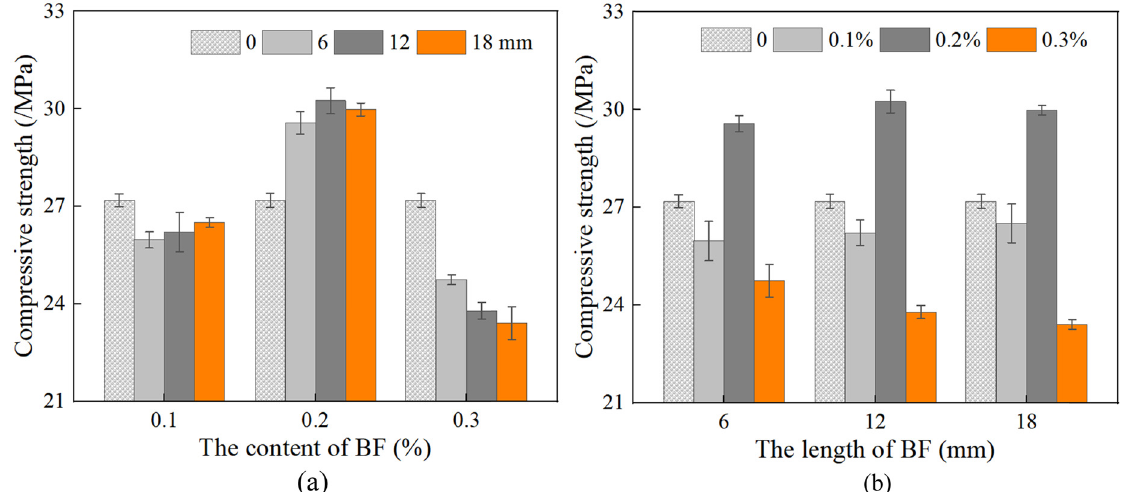
Figure 8: E ff ect of BF on the compressive strength of RAC. ( a ) RAC with di ff erent BF contents. ( b ) RAC with di ff erent BF lengths.